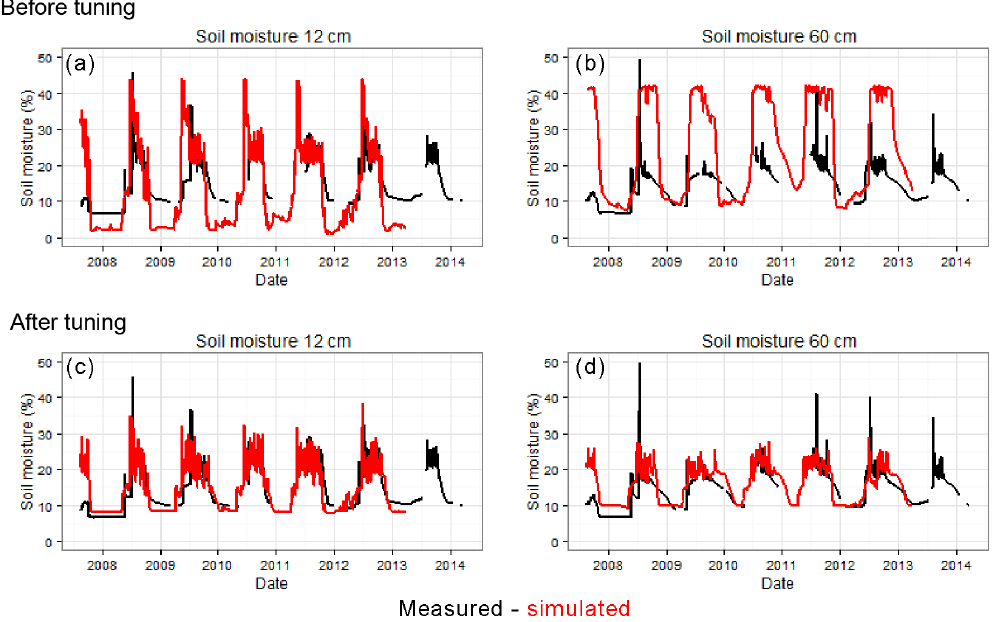
Figure 9. Comparison of the simulated (red) and measured (black) soil moisture data at 12cm (left panels) and 60cm (right panels) at SCH. Panels (a) and (b) show the results for soil moisture of the best thermal calibration, while (c) and (d) show the results after a further calibration of the soil physical parameter of the water retention curve, showing that the calibration can be further improved with additional data sets.